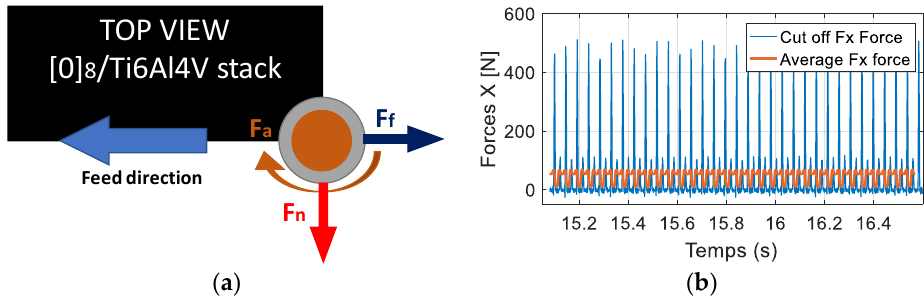
Figure 5. Cutting forces setup: ( a ) force direction layout within [0] 8 /Ti6Al4V stack; ( b ) feed force